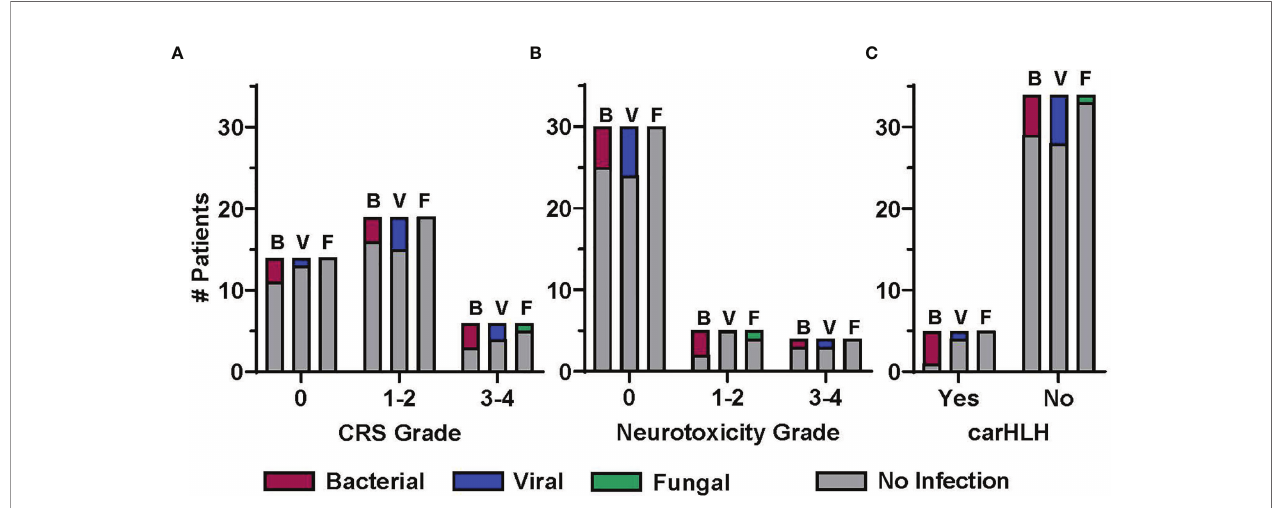
FIGURE 3 | Association between infection and post CD19-CAR T cell therapy immune mediated side effects. The proportion of patients experiencing at least one infection in the early post CAR T cell therapy period (day 1 to day 28), displayed by infection category and severity of CAR T cell therapy related immune mediated side effects (CRS, cytokine release syndrome; NTX, neurotoxicity; carHLH, CAR-associated hemophagocytic lymphohistiocytosis). Patients with at least 1 infection in a given category (B, bacterial; V, viral; F, fungal) are presented in the colored bars, with a patient contributing up to one infection per category. Patients not having an infection in the given category are accounted for in the gray bar. Distribution is by patients by highest grade (A) CRS and (B) neurotoxicity, or presence/absence of (C) carHLH.